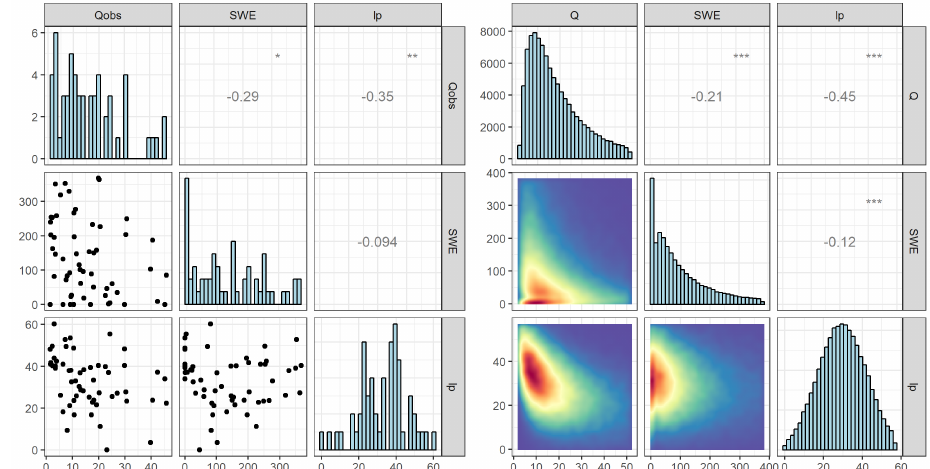
Figure 5. Correlation scatterplots for initial conditions (snow water equivalent, SWE, in mm; soil moisture deficit, l p , in mm; initial discharge, Q obs , in m 3 s − 1 ) for the Krinsvatn catchment for POT events (flood events over the 0.9 quantile, 57 observations). Scatterplots for observed quantities are shown on the left and simulated on the right (based on 100000 simulations). The stars represent the degree of significant correlation.